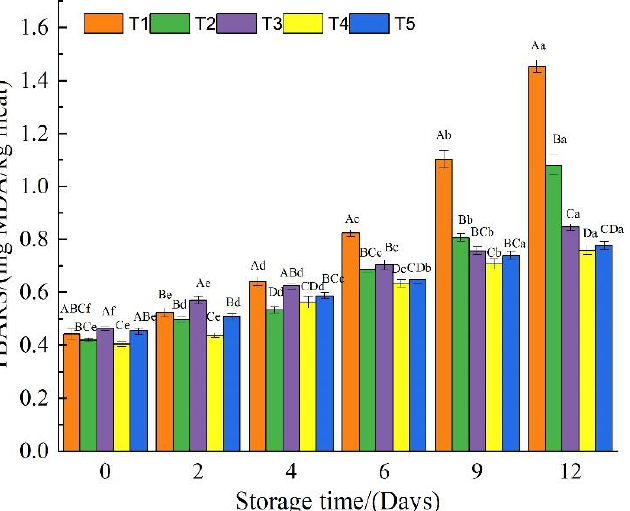
Figure 5. The thiobarbituric acid reactive substances of beef samples from different treatment groups during storage. T1: Control, beef samples immersed in distilled water; T2: Beef samples treated with GEL-CHI-GLY edible coating; T3: Beef samples treated with GEL-CHI-GLY-CA edible